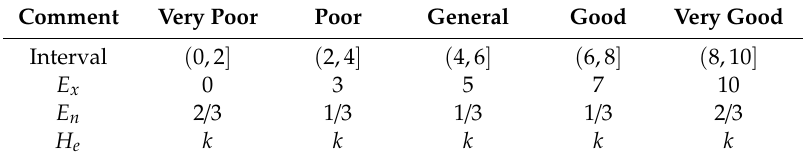
Table 4. Qualitative comments corresponding to the change interval and cloud model